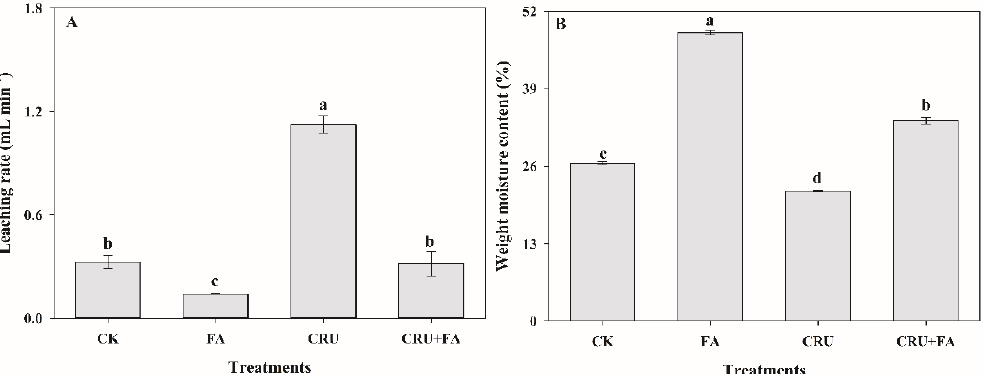
Figure 4. The leaching rate ( A ) and weight moisture content ( B ) after adding FA. Treatments or treatment components: CK (Control no added fertilizer); FA (fulvic acid 90 kg ha −1 ); CRU (N from controlled-release urea 450 kg ha −1 ); CRU+FA (N from controlled-release urea 450 kg ha −1 , fulvic acid 90 kg ha −1 ). Bar heights represent the averages of three replicates and error bars represent ± SE. Within each graph, means followed with the same letter were not significantly different based on a one-way ANOVA followed by Duncan’s multiple-range test ( p > 0.05).